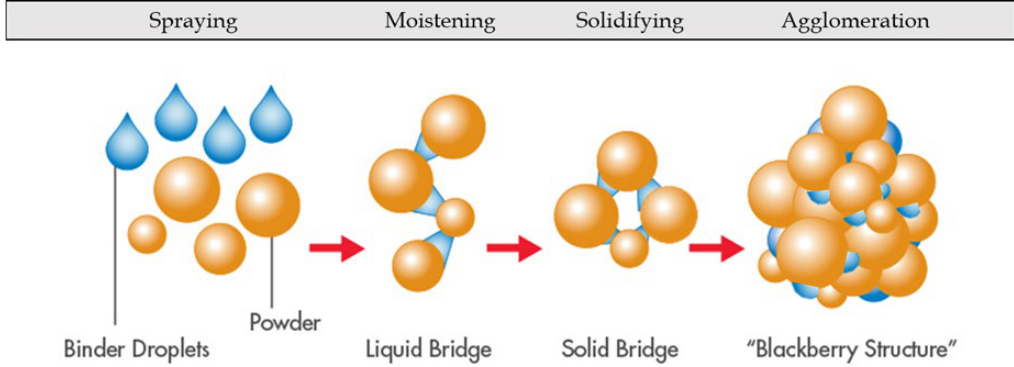
Figure 5. Fluidized bed spray-drying process principle of spray agglomeration